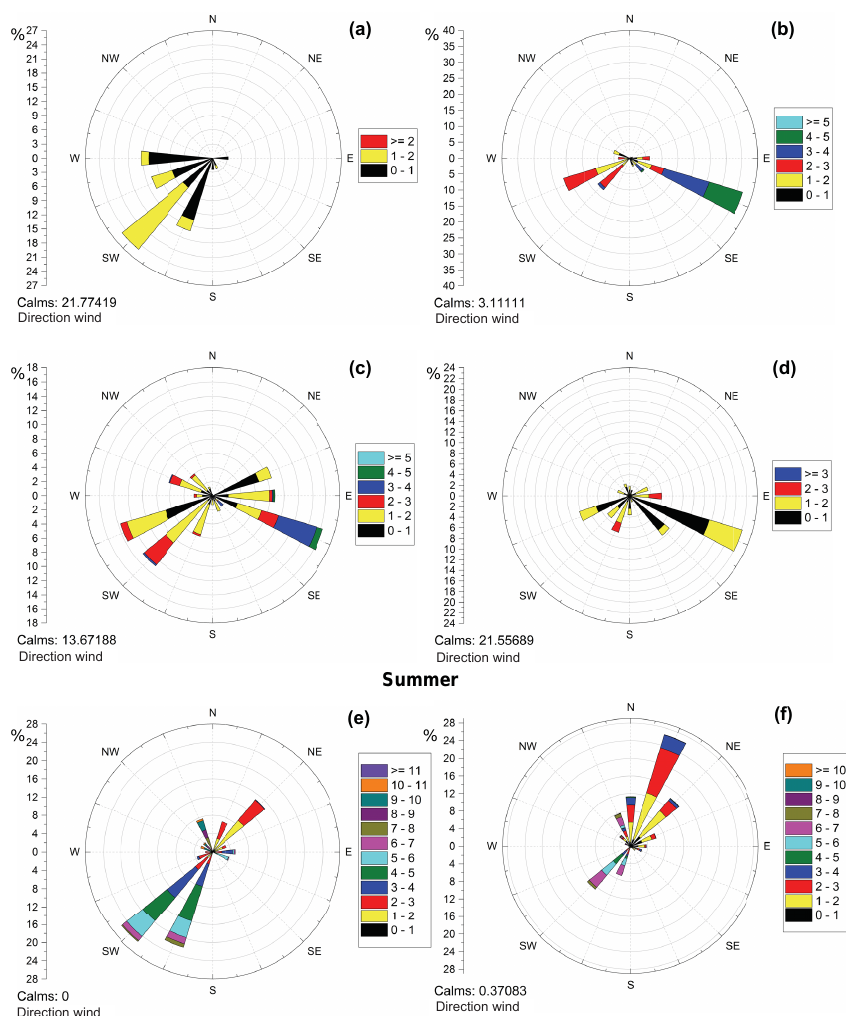
Figure 5. Wind rose obtained from the measured wind speed and direction at the CCT (33m). Springtime wind rose timely coincident with (a) homogeneous profiles (HO); (b) positive gradient profiles (PG); (c) negative gradient profiles (NG); (d) decoupled negative gradient profiles (DNG). Summertime wind rose timely coincident with (e) homogeneous profiles (HO); (f) profiles impacted by shipping emissions